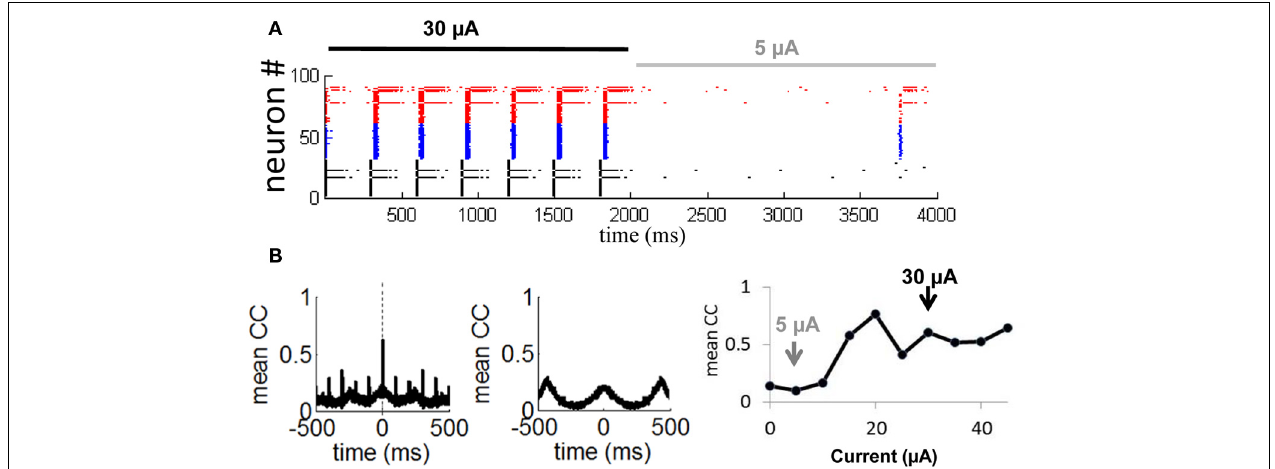
(B) Mean cross-correlation of the network during presentation of a strong current (left panel) and a weak current (middle panel). Right panel: Mean cross-correlation as a function of external current. Black and gray arrows show a weak ( I ext = 5 μ A) and strong ( I ext = 30 μ A) current as simulated in (A) . Vertical dashed line: zero